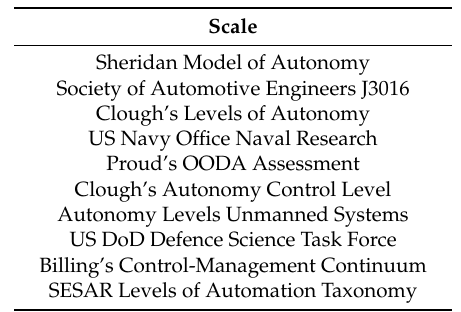
Table 2. Various automation/autonomy scales (after Reference [10]). SAE—Society of Automotive Engineers; US—United States; OODA—Observe, Orient, Decide, and Act; DoD—Department of Defence; SESAR—Single European Sky Air Traffic Management Research.